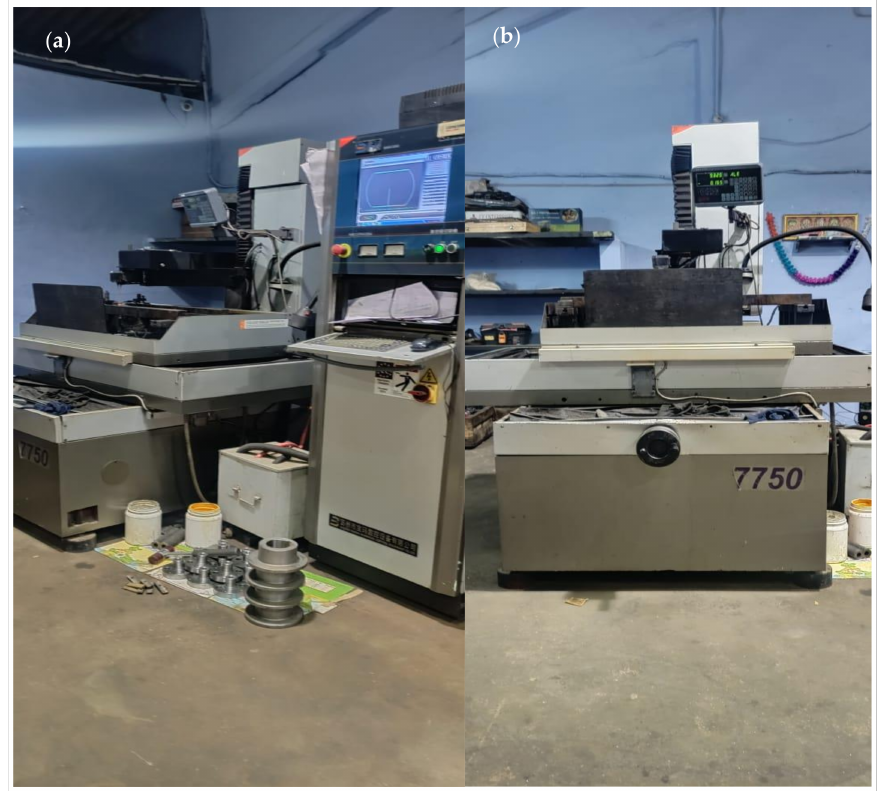
Figure 4. Wire EDM machine set up. ( a ) Isometric view, ( b ) Front